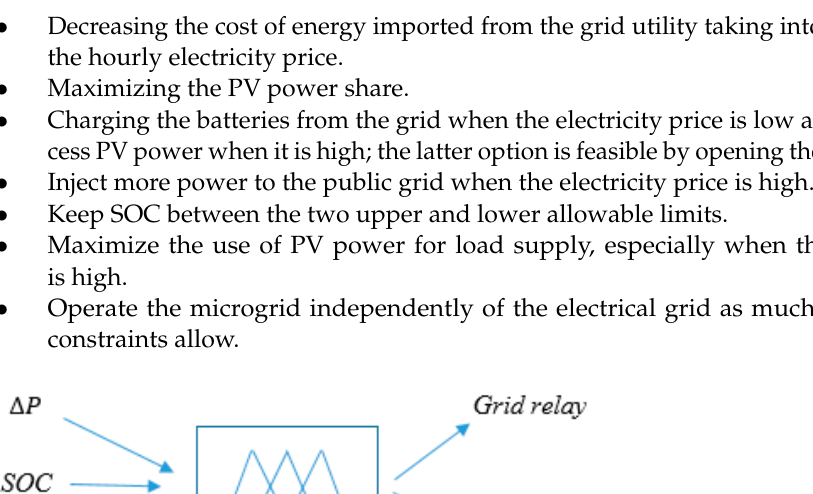
Figure 3 . Proposed fuzzy energy manager.